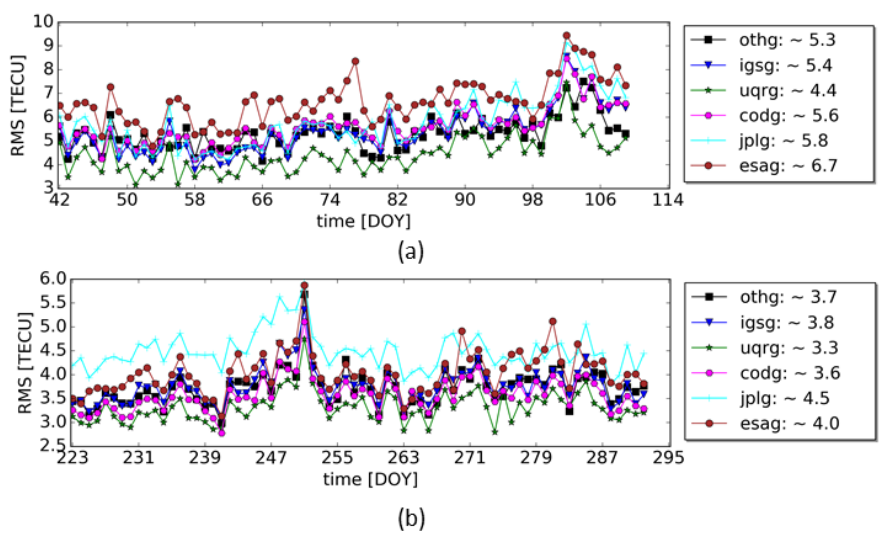
Figure 6. Comparison of DGFI-TUM’s VTEC values with the IAAC solutions in terms of RMS deviations. The daily RMS deviations are shown in ( a ) for the data sets of 2015 and in ( b ) for the year of 2017. ( a ) includes comparisons with respect to the altimeter VTEC data from the Jason-2 mission whereas ( b ) refers to the data from the Jason-3 mission. The label “othg” stands for the presented approach.